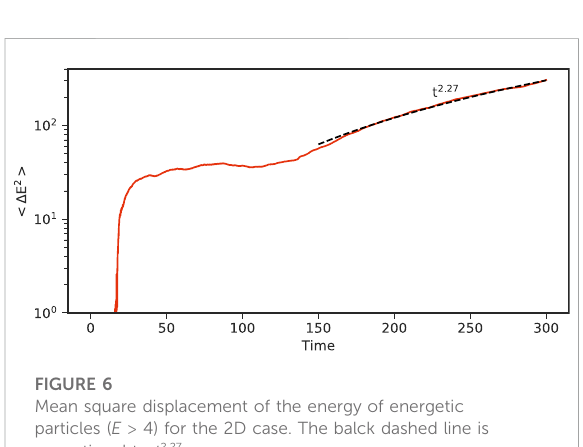
FIGURE 6 Mean square displacement of the energy of energetic particles ( E > 4) for the 2D case. The balck dashed line is propotional to t 2.27